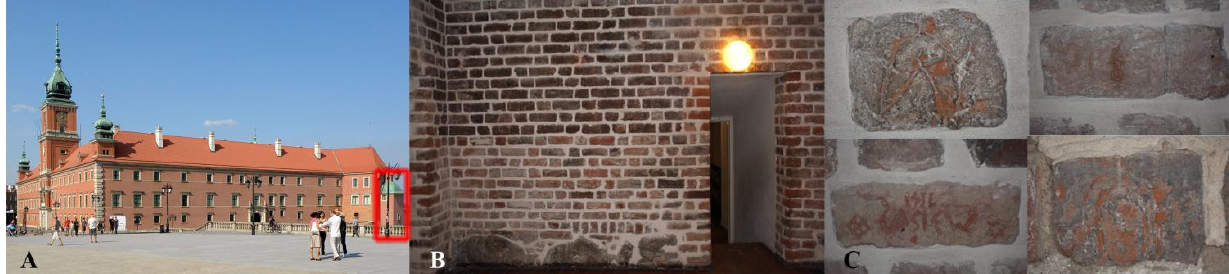
Figure 1. A) The Royal Castle in Warsaw with the Justice Court Tower marked in red, B) one of the processed walls, C) examples of